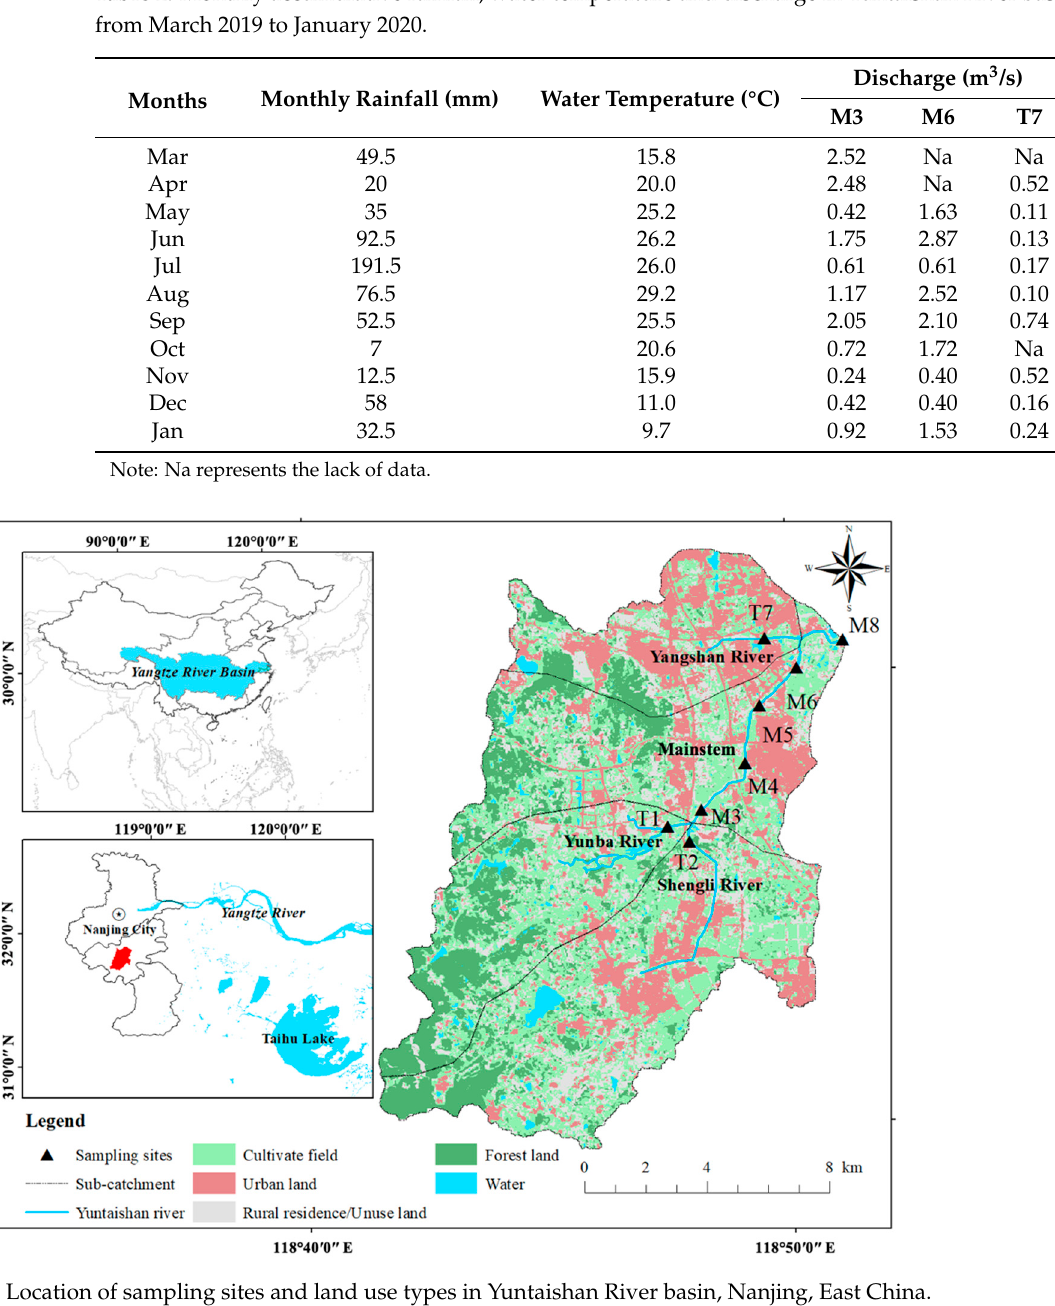
Table 2. Monthly accumulative rainfall, water temperature and discharge in Yuntaishan River basin